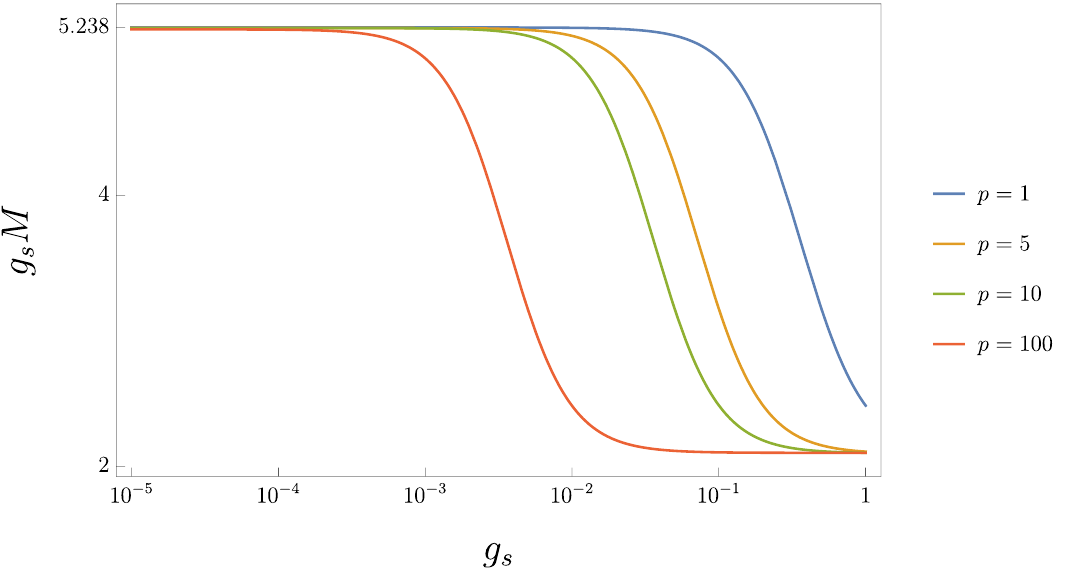
Figure 7. A plot of g s M over g s for different values of p . The region above the curves is where V tot has a positive maximum. For g s (cid:28) 1 and g s (cid:29) 1 the curves asymptote again towards g s M → 5 . 238 and g s M → 2 . 086 , respectively. Note that when p/M > 0 . 08 this maximum is not in a controlled